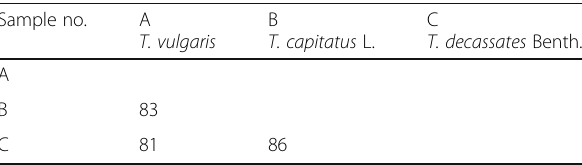
Table 7 Genetic similarity matrix within the studied Thymus species based on AFLP data Sample no.